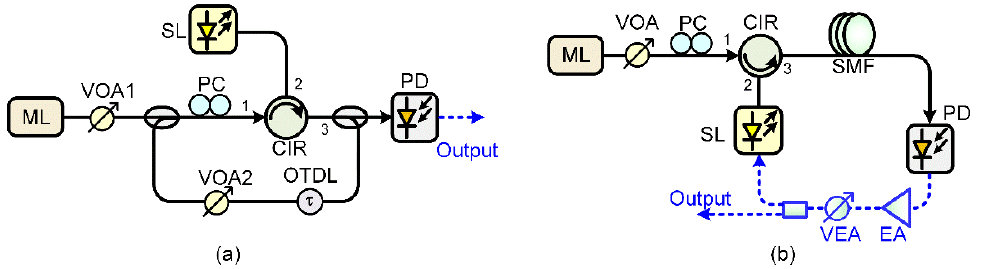
Figure 6. Photonic microwave stabilization for P1 dynamics using a delayed feedback cavity. ( a ) Optical feedback stabilization; ( b ) optoelectronic feedback stabilization. OTDL: optical tunable delay-line; SMF: single-mode fiber; VEA: variable electrical attenuator; EA: electrical amplifier.